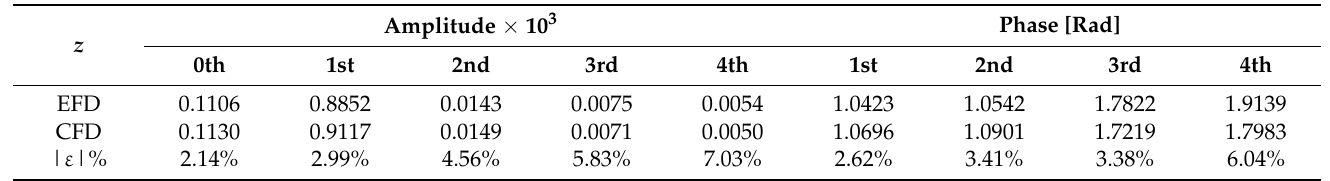
Table 16. Harmonic amplitudes and phases of heave ( z ) for the FRxz ϕθ beam waves scenario.